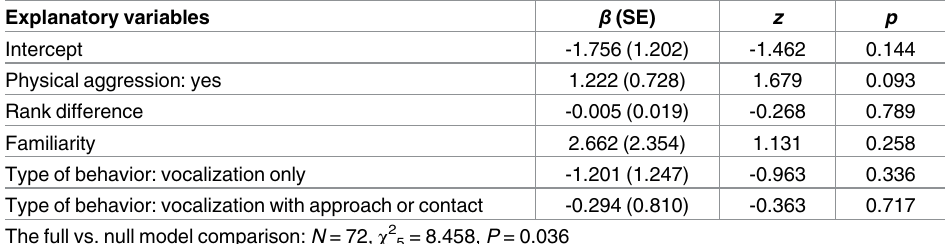
Table 5. GLMM logistic regression results for the effect of type of interaction, conflict characteristics, and relationship with the former opponent on the probability of receiving further aggression after post-conflict interactions.